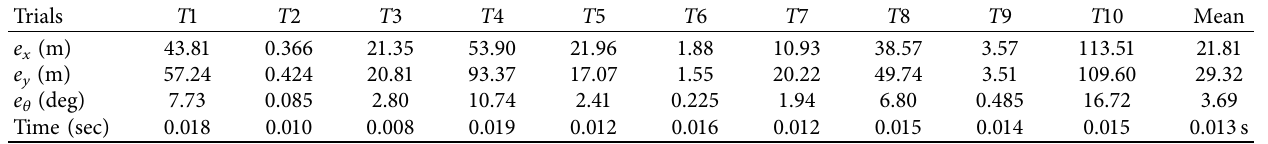
Table 4: The mean of the trials with the EKF (one landmark and non-Gaussian noise). Trials